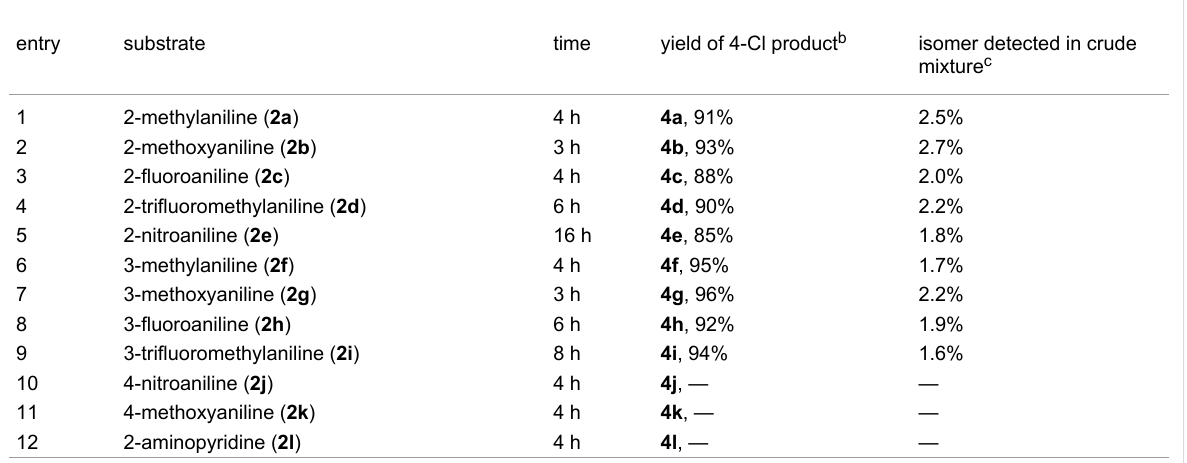
Table 2: para -Chlorination of aniline analogues (100 mmol scale) using CuCl 2 in 1-hexyl-3-methylimidazolium chloride ( 3a ). a